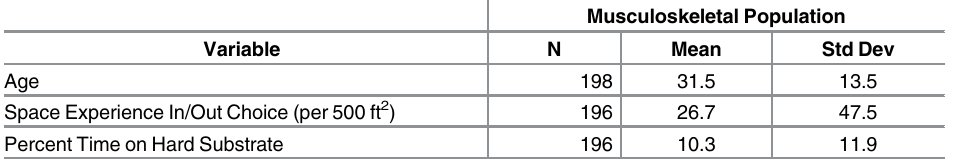
Table 4. Descriptive statistics for variables retained in final multi-variable regression model for the population with MS